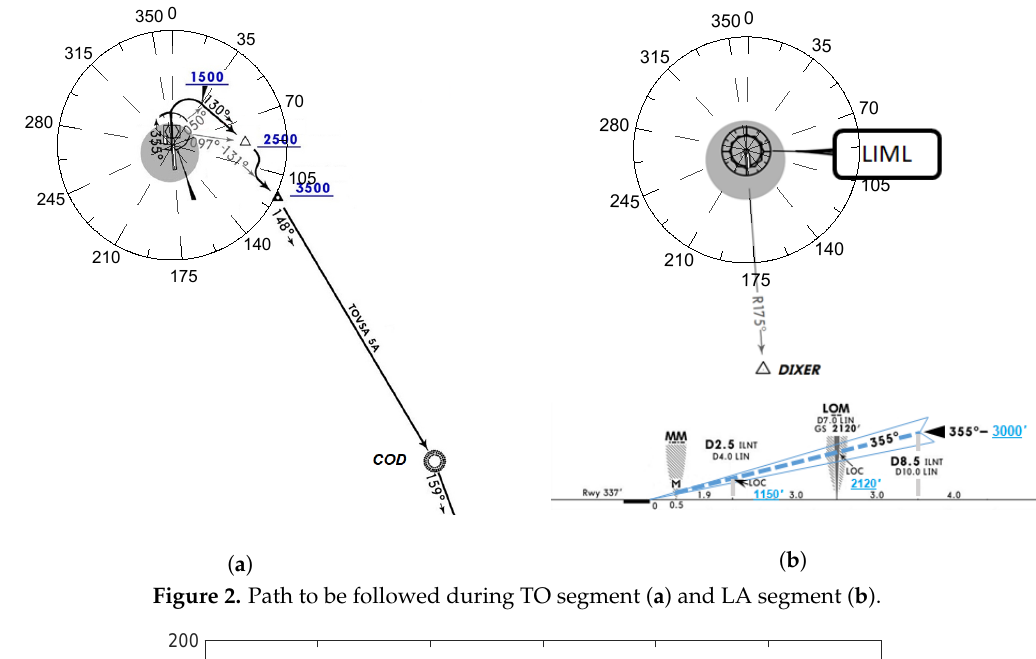
Figure 2. Path to be followed during TO segment ( a ) and LA segment ( b ).